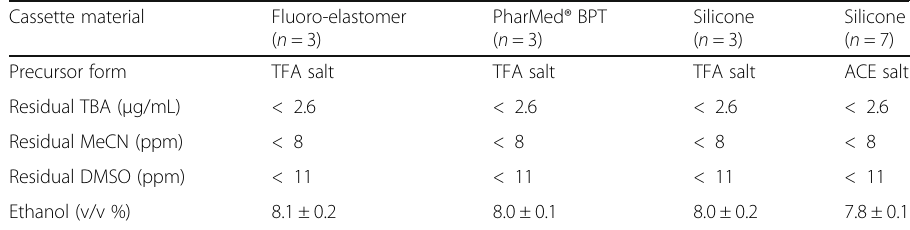
Table 2 Comparison of residual TBA, MeCN, DMSO, and ethanol among three cassette types Cassette